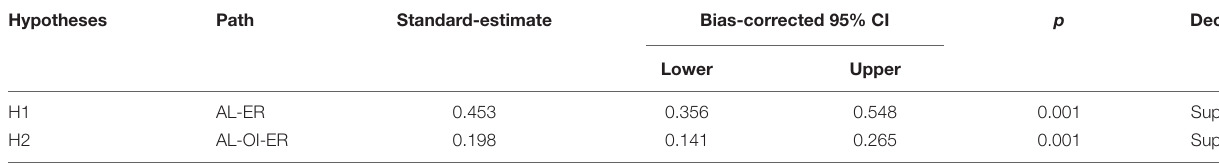
TABLE 3 | Standardized direct and indirect effects with 95% confidence intervals. Hypotheses